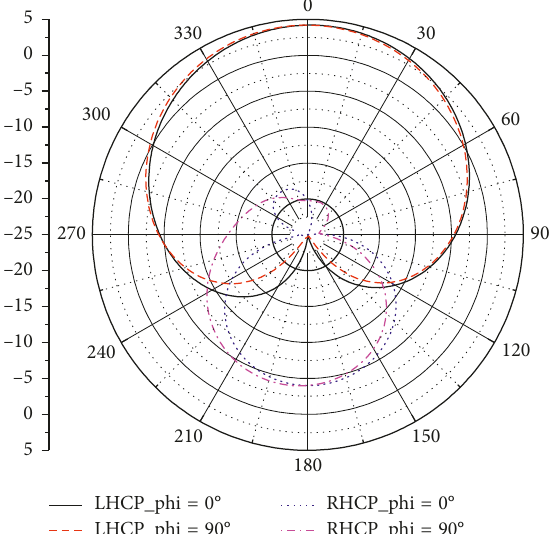
Figure 9: The radiation patterns of the CP antenna with and without the C-shaped parasitic strip.